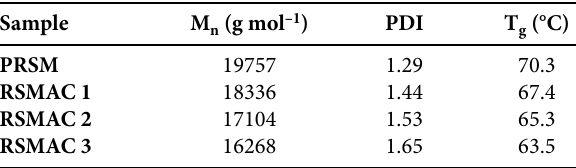
Table 3. Tg values of the PRSM and RSMAC 1-3